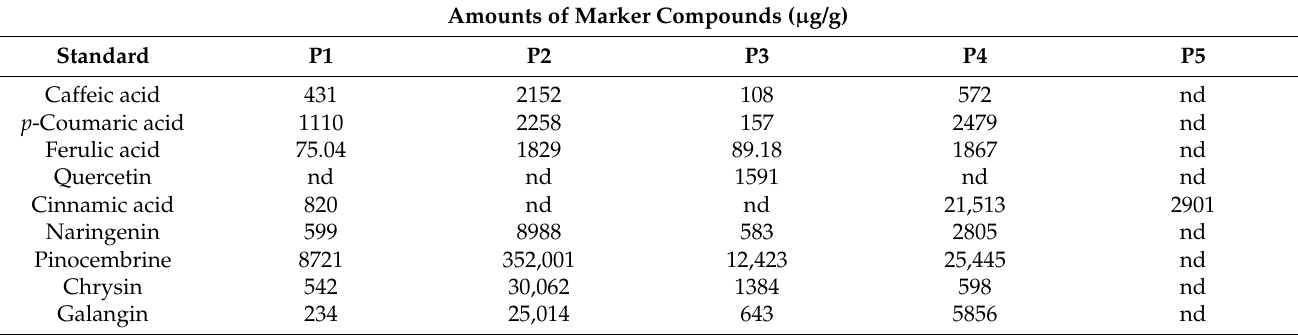
Table 3. The levels of nine marker compounds obtained from the analysis of Moroccan and Palestinian propolis. Amounts of Marker Compounds ( µ